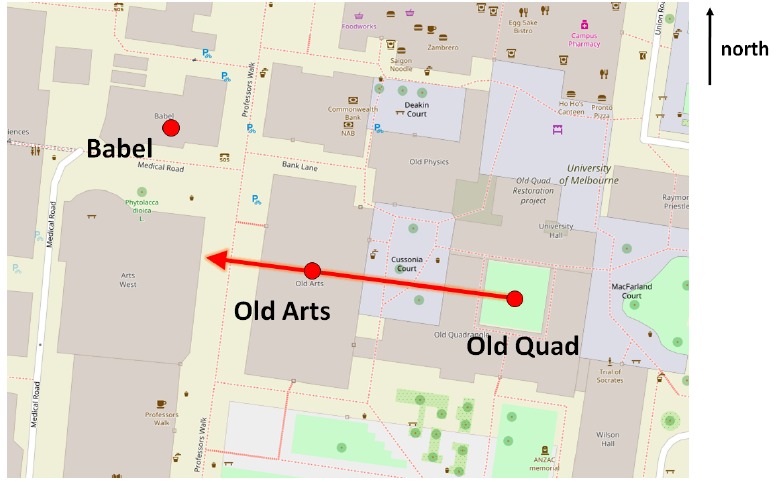
Figure 16. The locations of the three places mentioned in the descriptions above, with a red arrow indicating the walking